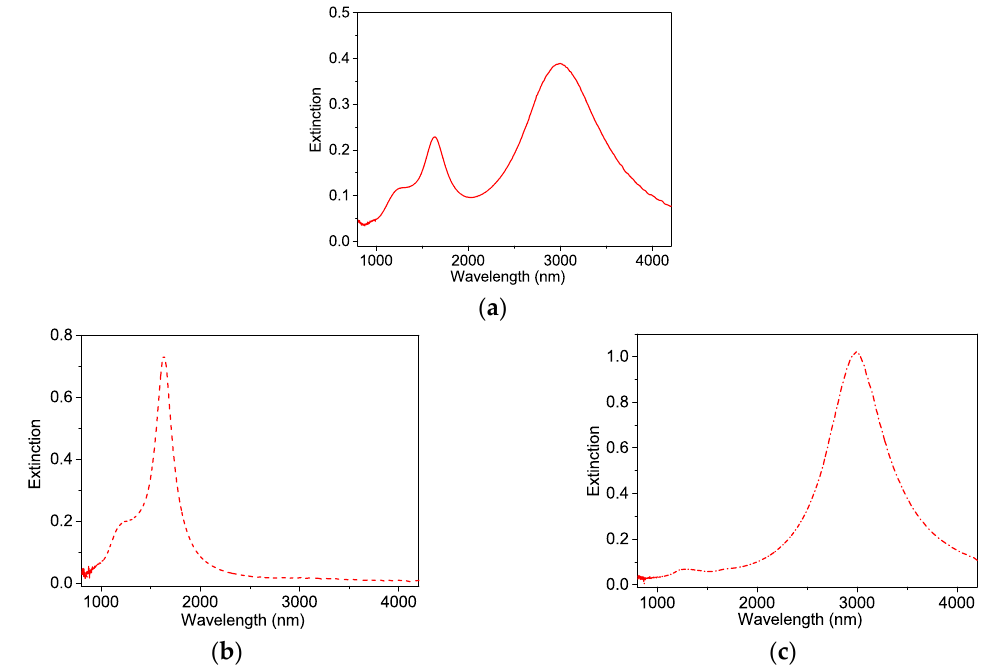
Figure 2. Extinction spectra of gold curvilinear nanorods using various polarization illumination; ( a ) solid line: unpolarized, ( b ) dashed line: x -direction polarized, ( c ) broken line: y -direction polarized.